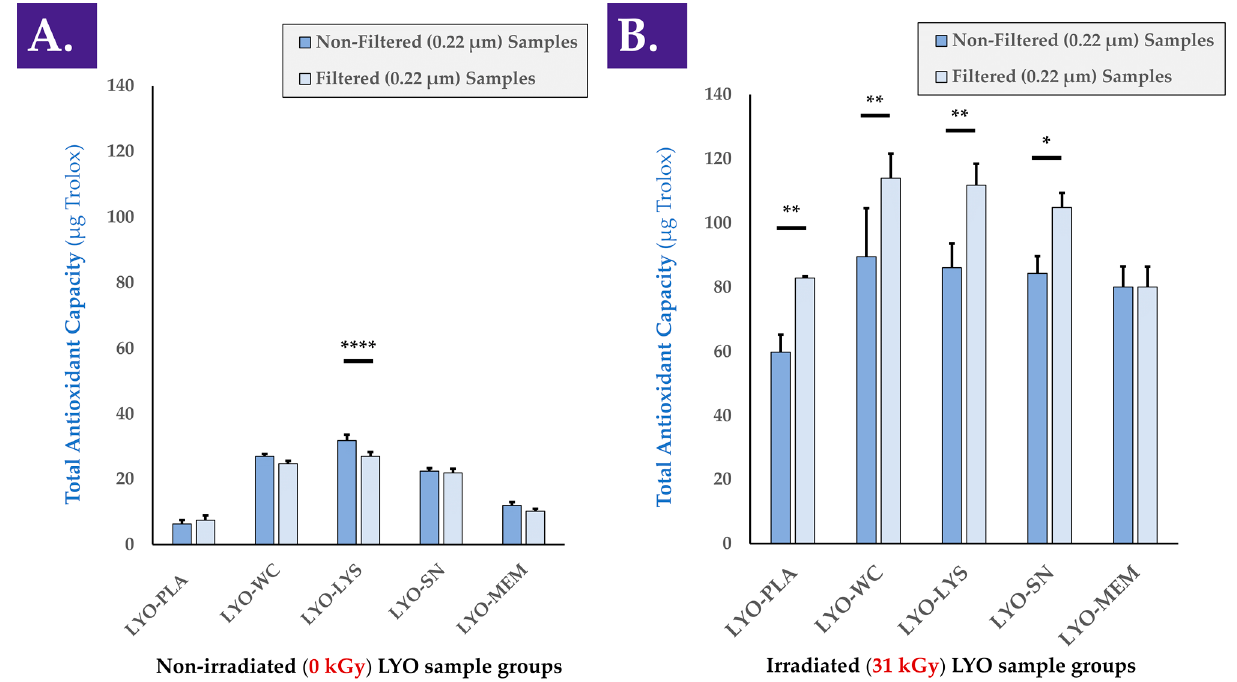
Figure 2. TEAC values of various non-irradiated ( A ) and γ -irradiated (i.e., irradiation dose of 31 kGy, ( B )) progenitor tenocyte extracts, before and after 0.22 µ m filtration, respectively. Results outlined a strong response (i.e., relative increase) of the γ -irradiated samples in TEAC measurements compared respectively to the same non-irradiated samples (( B ) vs. ( A )). Significant statistical differences (i.e., * or p value < 0.05), very significant statistical differences (i.e., ** or 0.001 < p value < 0.01), or extremely significant statistical differences (i.e., **** or p value < 0.0001) were found between the presented mean values. kGy, kiloGray; LYO-PLA, lyophilized placebo sample; LYO-LYS, lyophilized lysate fraction; LYO-MEM, lyophilized membrane fraction; LYO-SN, lyophilized soluble fraction; LYO-WC, lyophilized whole-cell fraction.